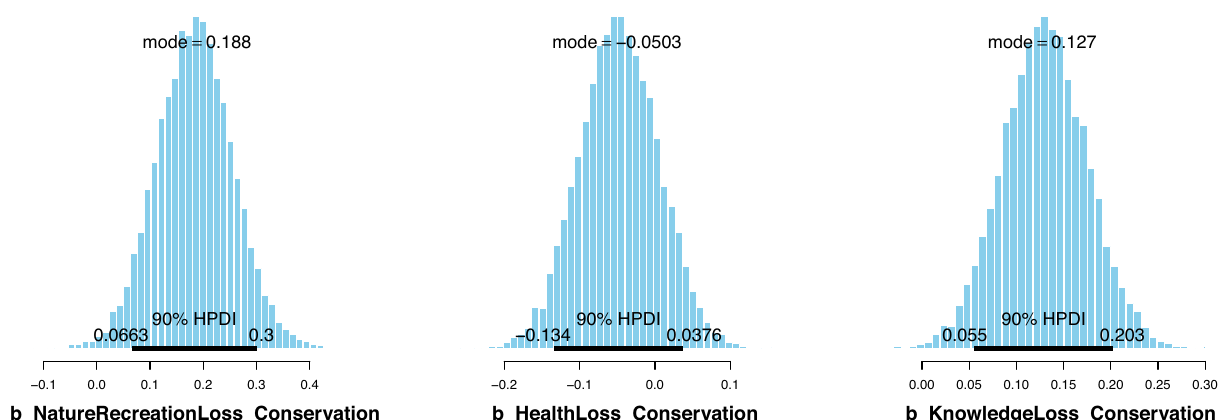
Fig. 6 Model 1 ’ s posterior distributions with priors as norm (1,0.5). The plot shows the probability distributions of the parameters with the highest probability range located in the middle. The thick black line at the bottom of the illustration demonstrates the HPDI at 90% of the distribution.